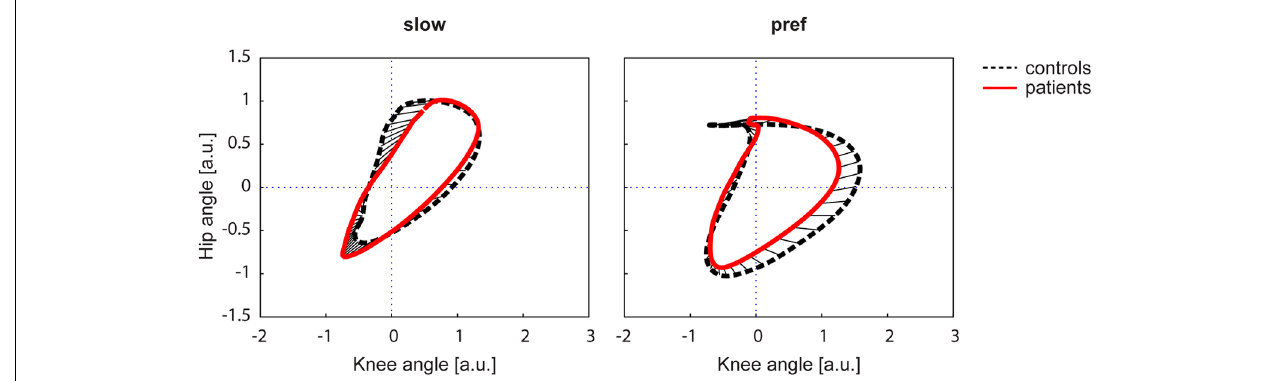
FIGURE 4 |The square root of the sum of squared distances (SSD) calculated the difference in shape of two figures. The cyclograms are shown after translation of the centroid to origin (zero) and uniform scaling.The